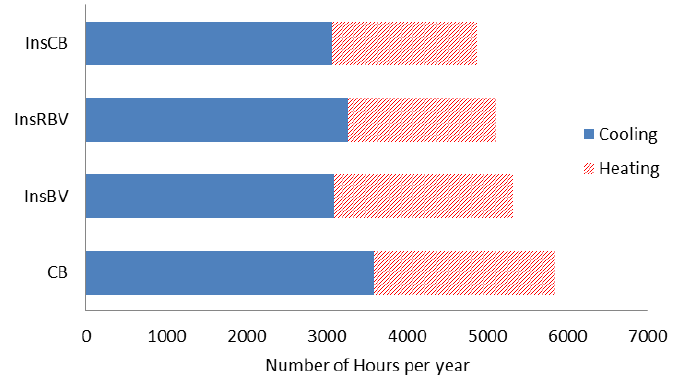
Fig. 6. Number of hours per year where heating and cooling was required based on AccuRate operating